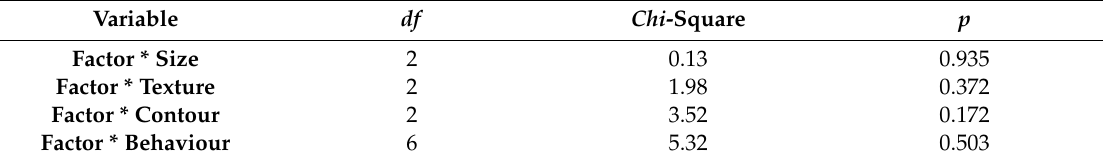
Table 3. Result of Wald chi-square test for the Preference per Q-factor interactions.